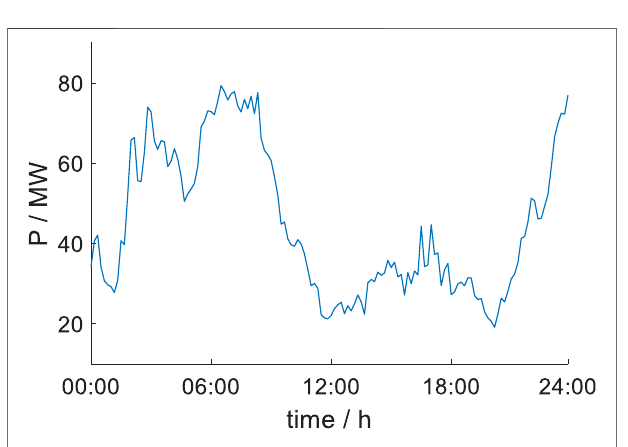
FIGURE 7 | Nodal voltage